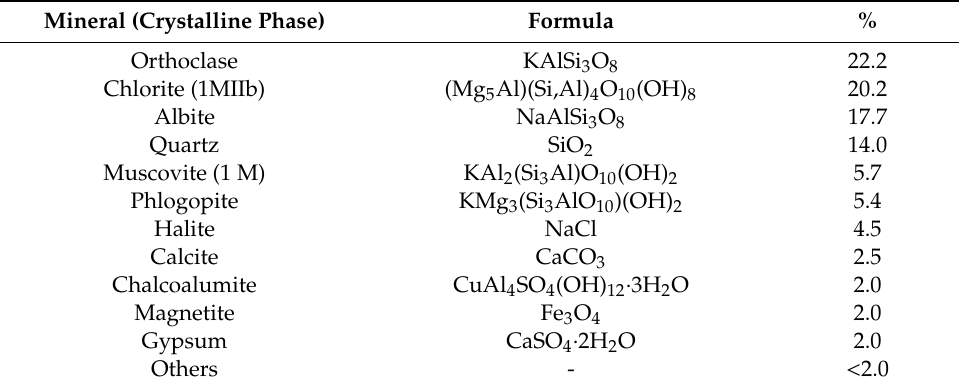
Table 3. Mineral composition of the ore